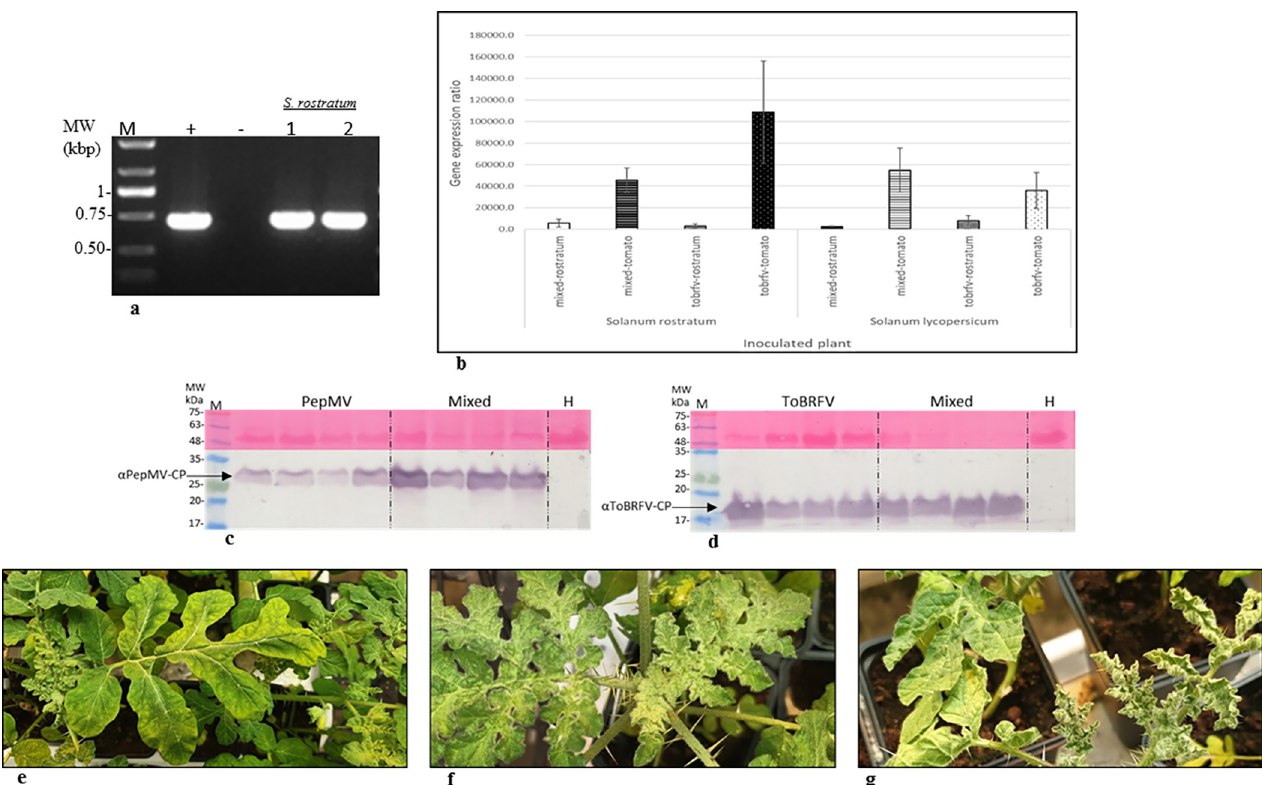
Fig 2. S . rostratum is a host of ToBRFV and PepMV-IL in single and mixed infections. (a) RT-PCR of ToBRFV-inoculated S . rostratum plants, confirmed by Sanger sequencing. (b) A graphical depiction of ToBRFV relative gene expression ratios 2^- ΔΔ Ct in comparison to the corresponding healthy controls (with the RPL8 endogenous gene). Four different inoculum sources were applied to each test plant: S . rostratum and S . lycopersicum . (c) Western blot analyses showing CP levels of PepMV-IL and (d) ToBRFV in singly and mixed-inoculated S . rostratum plants. (e) Symptomatic S . rostratum plants inoculated with PepMV-IL alone, and (f) ToBRFV alone or (g) with a mixture of ToBRFV and PepMV-IL showing leaf roll and serrated leaves. M, a molecular size marker; (+) positive control from ToBRFV-infected tomato plants; (-) healthy control; numbers represent different plants; arrows indicate the ToBRFV-CP, PepMV-CP and the Ponceau-S stained RuBisCO; H, a healthy